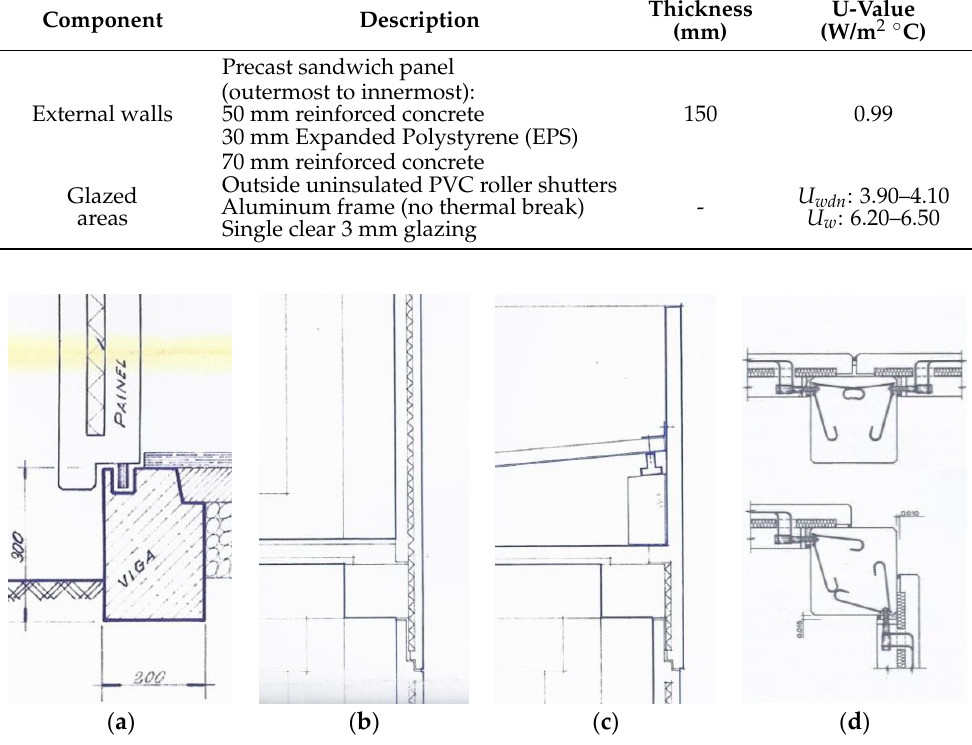
Figure 4. NK1 constructive details: ( a ) section representing the connection between external wall, structural beam, and ground floor; ( b ) section representing the connection between external walls, structural beam and internal floors; ( c ) section representing the connection between external wall, structural beam and roof; ( d ) plan representing the connections between columns and external walls (source: Covilhã and Fundão Municipalities Archives).